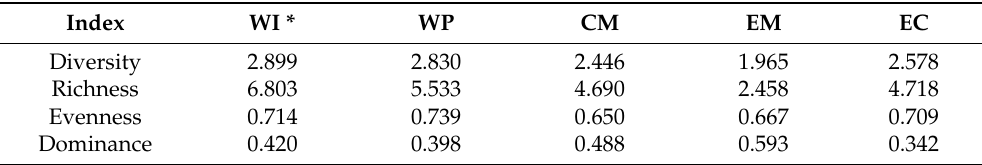
Table 2. Community indices of survey sites of the five regions in the adjacent areas of the DMZ, Korea, from 2015 to 2019.